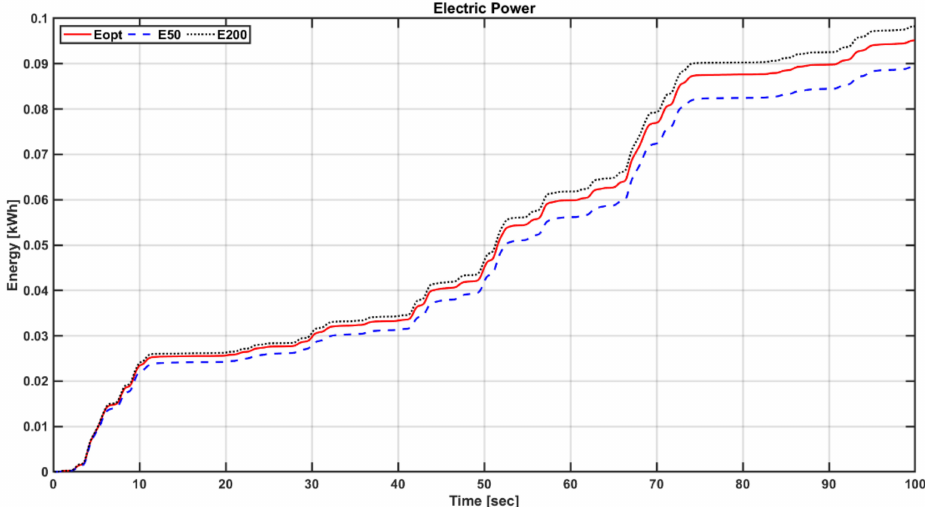
Figure 29. Output energy results of PTO system in integrated simulation according to the torque factor of load control under irregular wave ( v t = 0~42 m / s and Tp = 4.75 s).